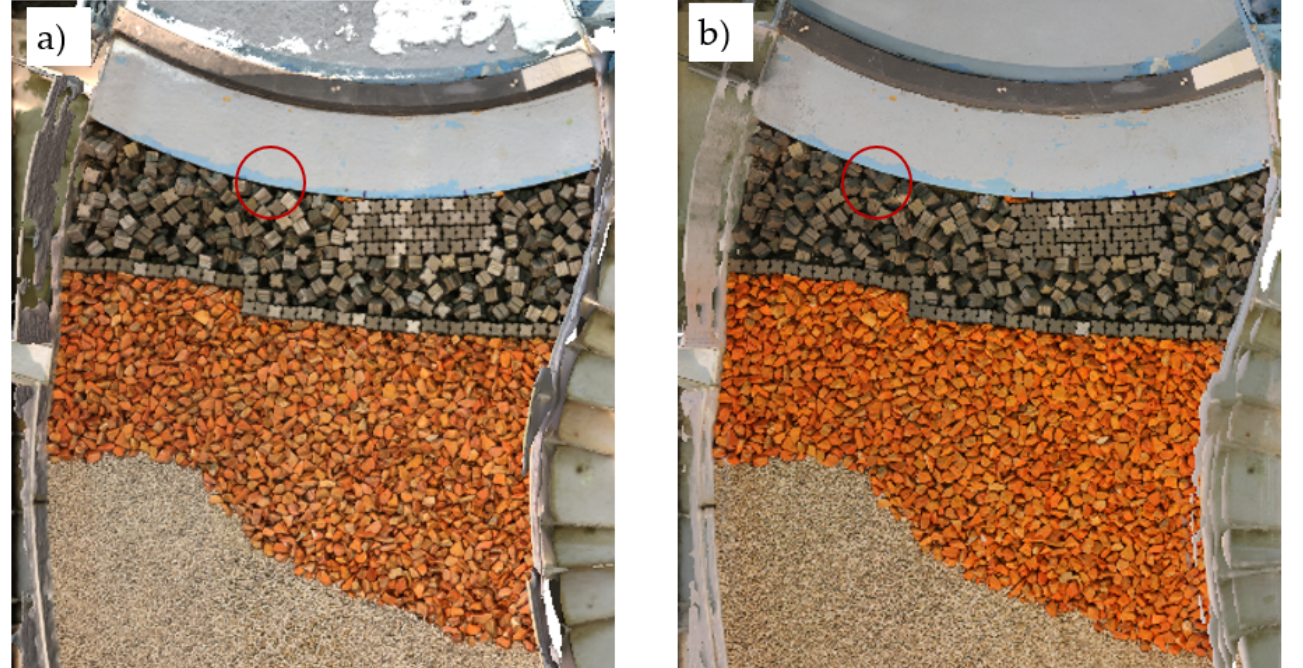
Figure 16. Comparison between the Antifer blocks location at the beginning and at the end of Test #4a. ( a ) Initial random placement configuration. ( b ) Antifer arrangement at the end of the experment. The local rotation of a few Antifer blocks is highlighted.